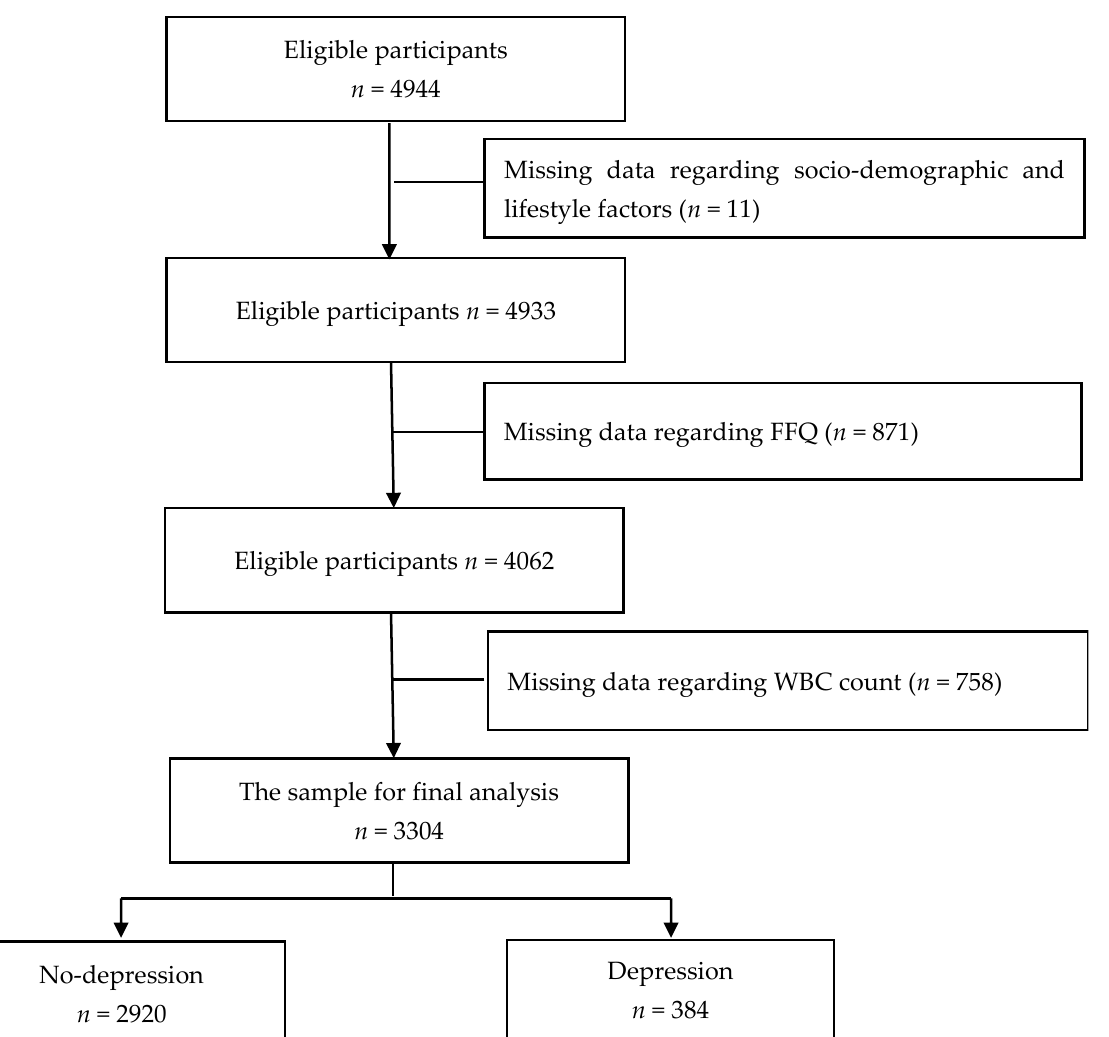
Figure 1. Flow diagram of the enrolment in the study.